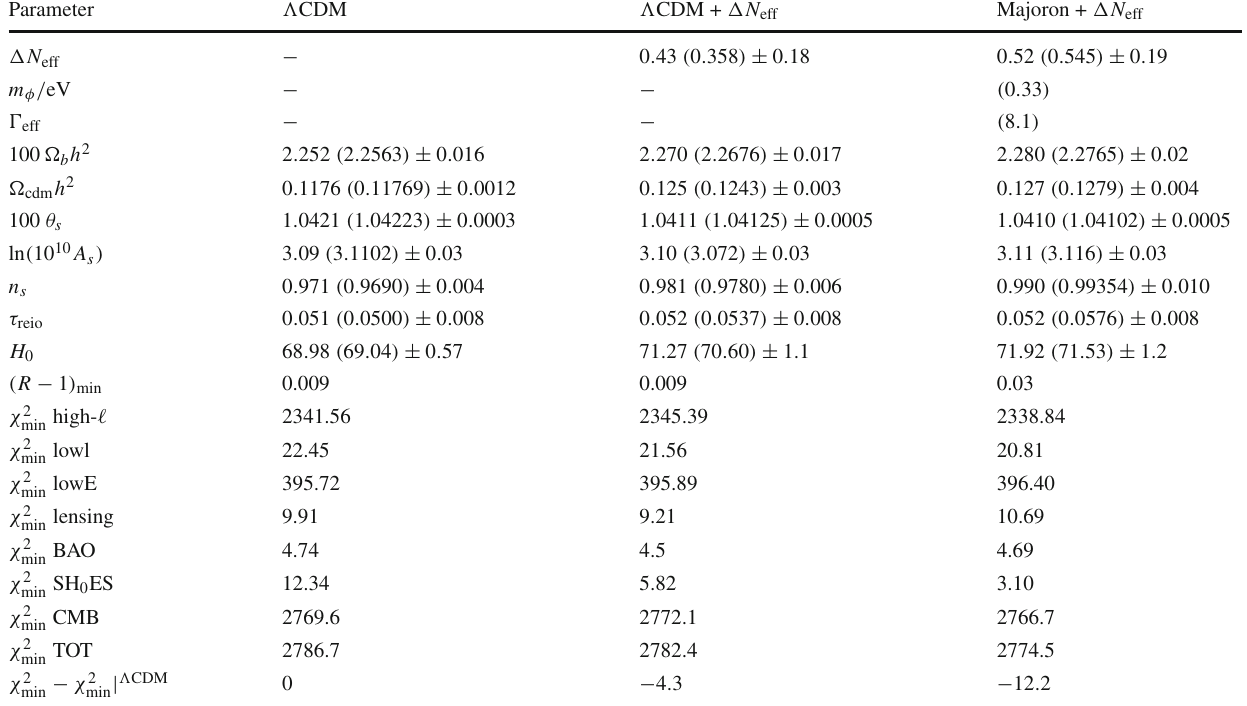
Table 1 Mean (best-fit) values with ± 1 σ errors of the cosmo- logical parameters reconstructed from our combined analysis of Planck2018+BAO+SH 0 ES data in each scenario. For comparison, the best-fit χ 2 we find for (cid:7) CDM using Planck2018+BAO data only